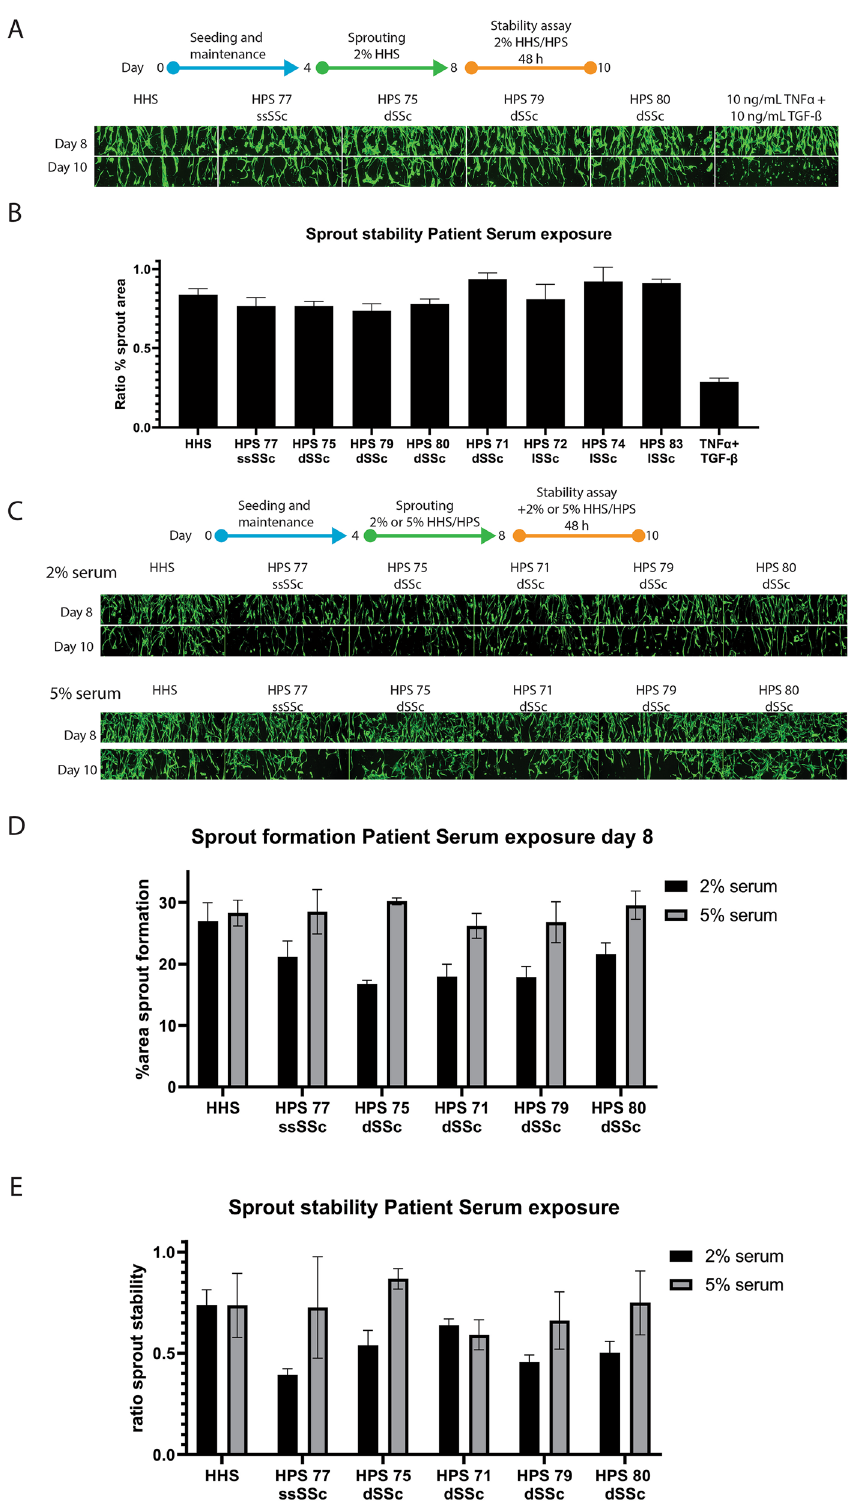
Figure 4. Exposure of sprouted HMVEC microvessels to sera from patients with systemic scleroderma. ( A ) Angiogenic sprouting was induced from day 4 till day 8 including 2% healthy human serum, followed by exposure for 48 h with 2% patient serum of 8 systemic scleroderma patients. Representative images before and after exposure are shown. ( B ) Bar graph presenting the ratio of the area covered by sprouts after versus before patient serum exposure. n = 3–6 shown is mean ± SEM. ( C-E ) Angiogenic sprouting was induced in the presence of 2% or 5% patient serum for 4 days. Subsequently, sprout stability was verified following four days of culture in absence of the sprouting cocktail with the addition of patient serum. Representative images are shown in ( C ), quantification of sprouting area at day 8 in ( D ) and the ratio of sprout stability in ( E ). n = 3–4, shown are mean ±